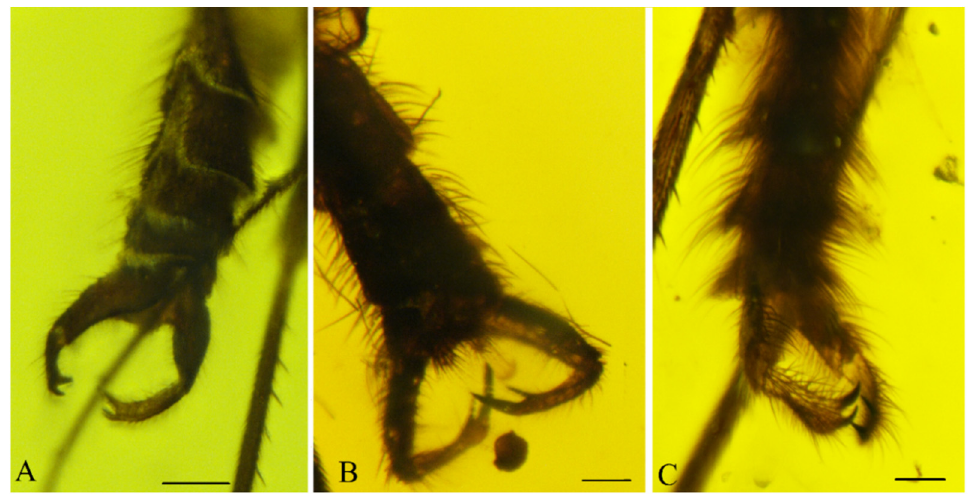
Figure 2. Male genitalia of Paleoplatyura agnieszkae sp. nov. ( A ), P. miae sp. nov. ( B ), and P. magnifica sp. nov. ( C ). Scale bar = 0.1 mm.